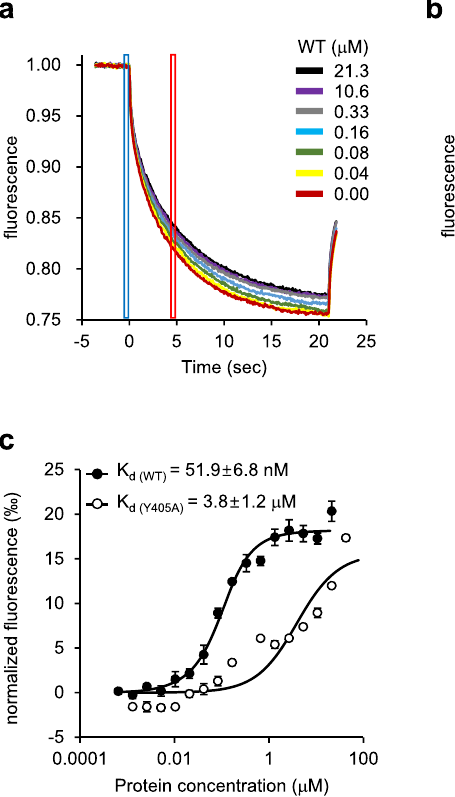
curves. Normalized fl uorescence is de fi ned as F hot / F cold . Each datum is the mean±standard error of the mean (SEM) of at least three independent experi- ments using the same batch of DM-puri fi ed protein. Source data is provided as source data fi